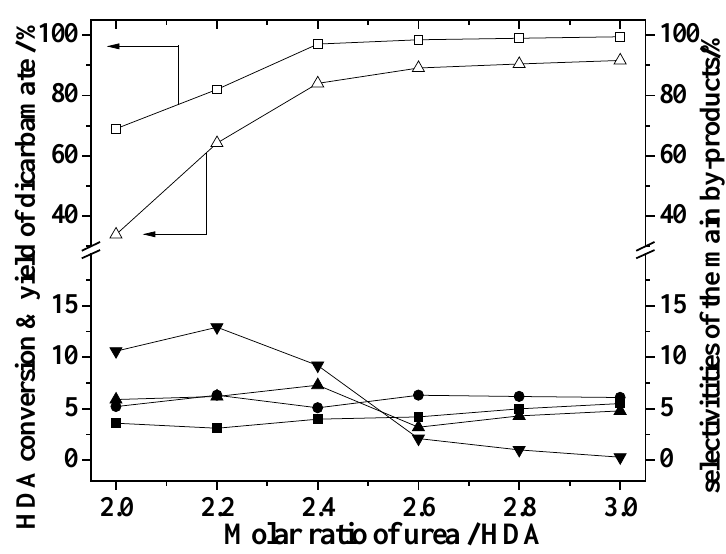
Figure 3. Effect of molar ratio urea/HDA on HDA conversion, yield of 2 and selectivities for the main byproducts ( 1 , 3 – 5 ). Reaction conditions: HDA: 0.9 mol; ZnAlPO 4 : 3.0 g; butanol: 7.74 mol (708.0 mL); time:6 h; reaction temperature: 493 K, reaction pressure: 1.2 MPa. (Legend: (□) HDA conversion; ( △ ) yield of dialkyl carbamate; ( ■ ), ( ▲ ), (●) and ( ▼ ) selectivity for 3 , 4 , 1 and 5 , respectively.). 1 : butyl